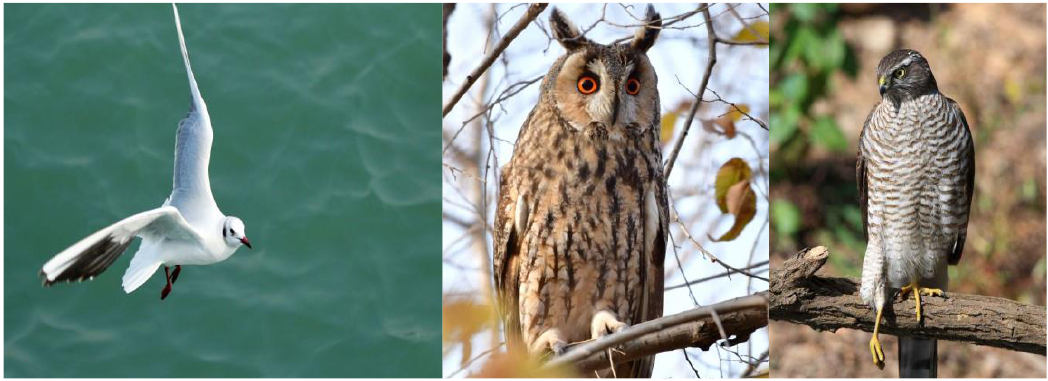
Figure 1. Left to right: seagull, long-eared owl, and